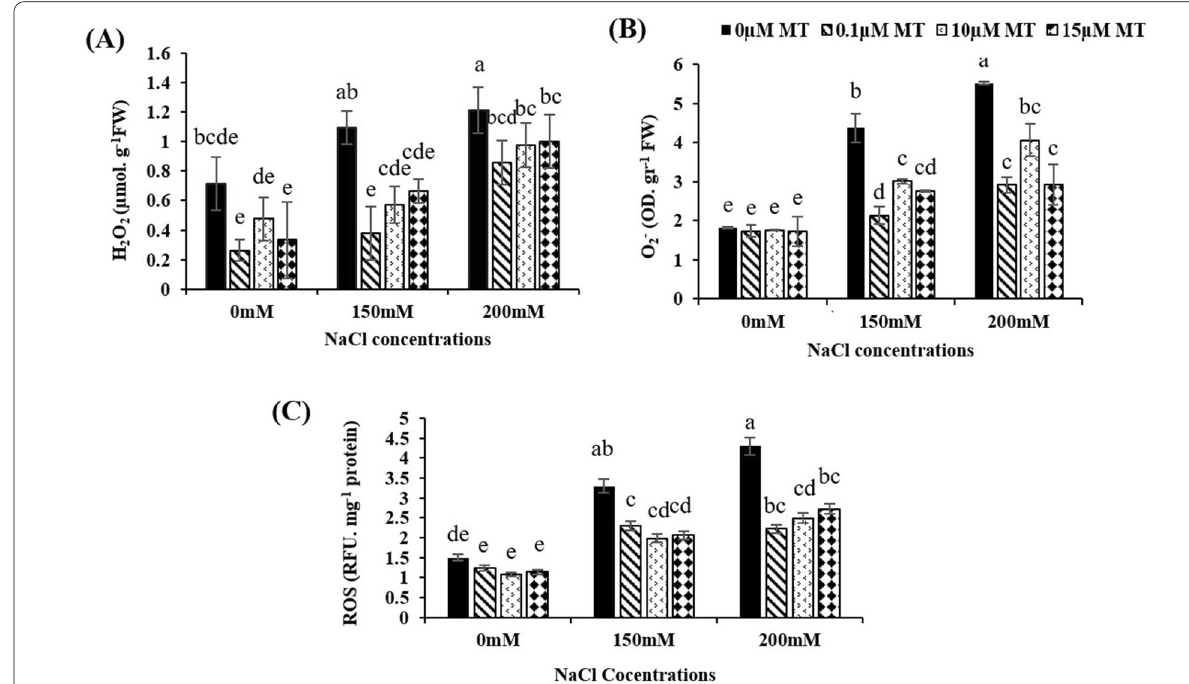
Fig. 1 Effects of melatonin (0, 0.1, 10, and 15 µM) and NaCl (150 and 200 mM) on H 2 O 2 ( A ), O − 2 ( B ) and ROS ( C ) content of alfalfa root. Data was collected after ten days of treatment with salt and melatonin. Data represents the mean of replicates